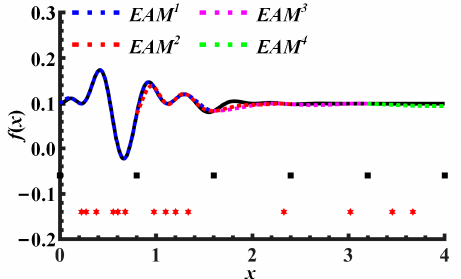
Figure 6. The construction of local embedded approximation models.